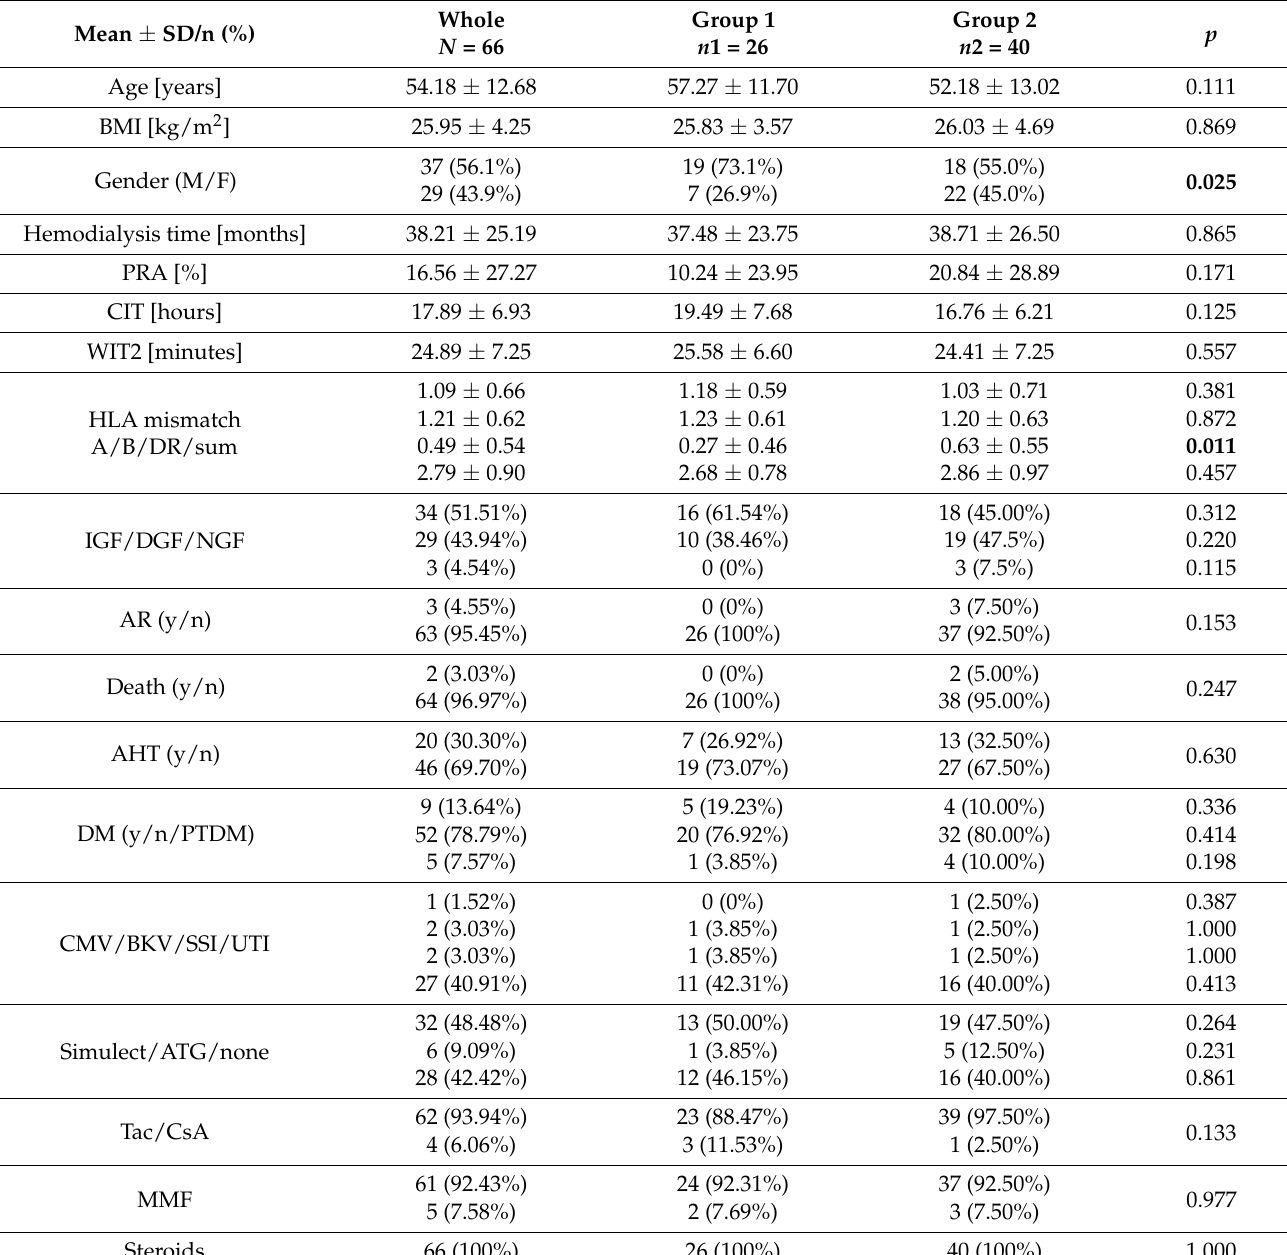
Table 4. Recipient-related parameters in the study group qualified for